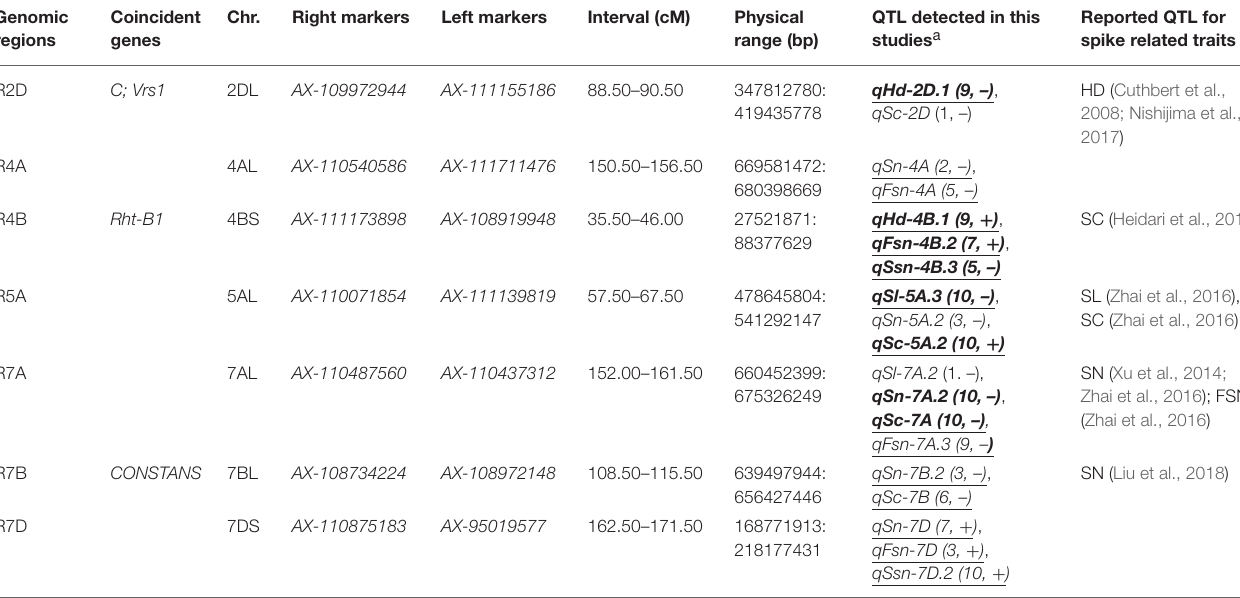
TABLE 3 | Seven genomic regions harboring the stable QTL in this